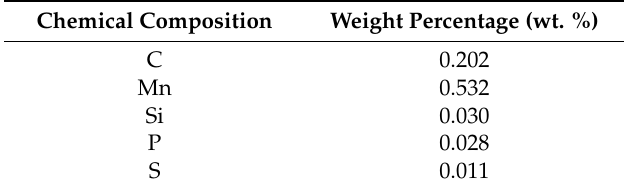
Table 5. Chemical composition for ASTM A36 steel, (wt.